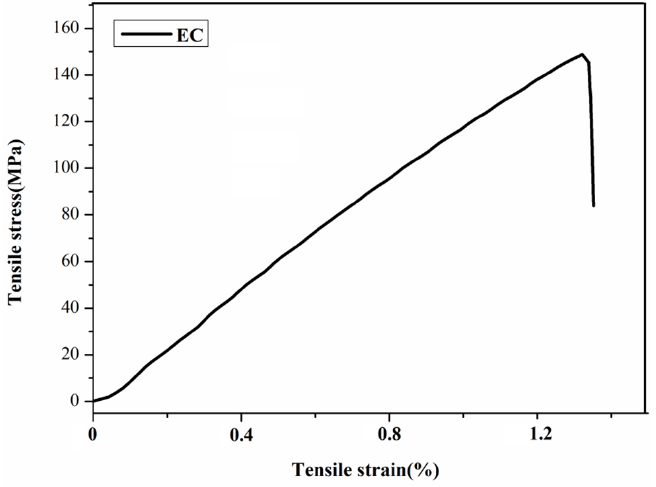
Figure 13. Tensile stress and strain of EC.